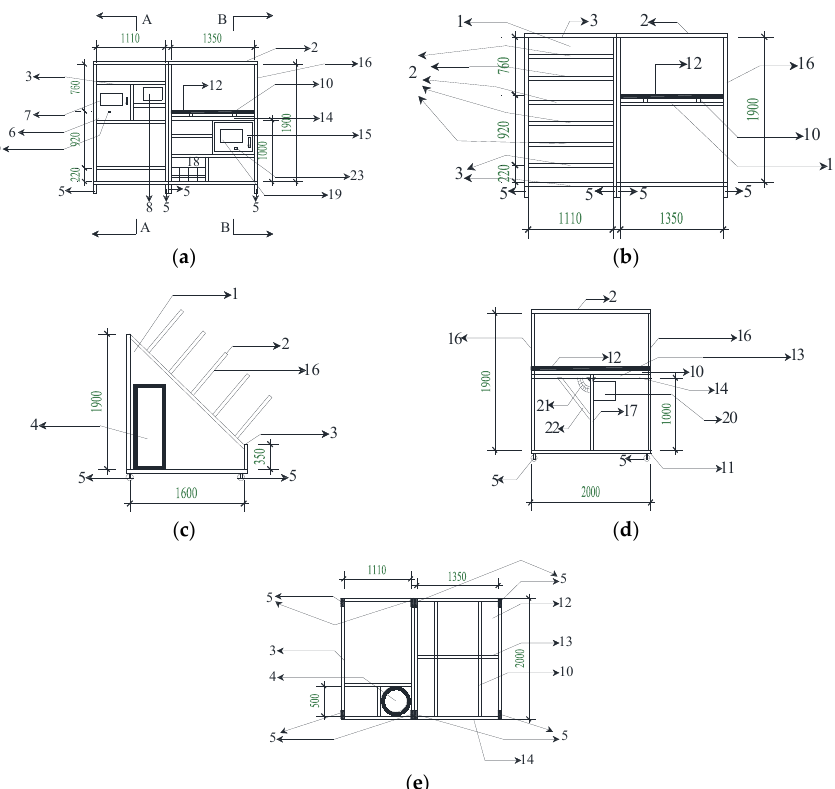
Figure 1. The appearance structure: ( a ) front view; ( b ) back view; ( c ) sectional view A; ( d ) sectional view B; and ( e ) bottom view.